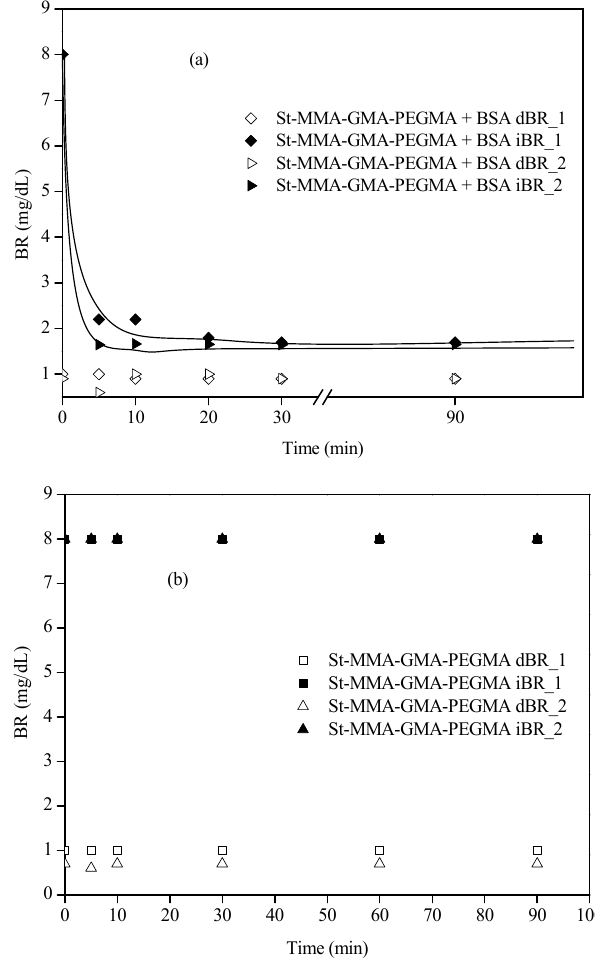
Figure 10. Kinetics of bilirubin removal from plasma by St-MMA-GMA-PEGMA particles with BSA ( a ) and without BSA ( b ), wetted with ethyl lactate. All of the experiments were carried out with 1.2 g of particles at 23.5 ◦ C, and with a flow rate of 120 mL/min.